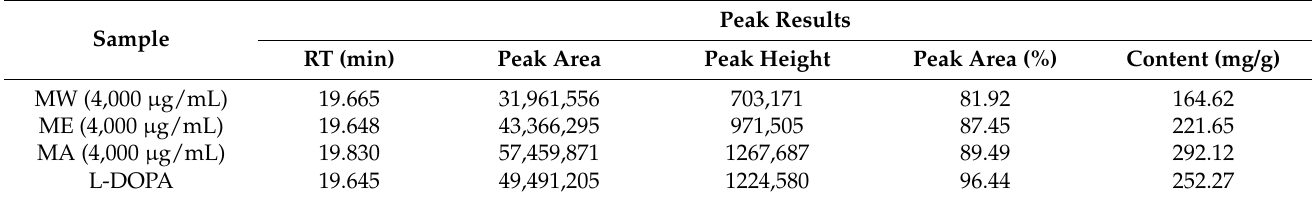
Table 1. L-DOPA content in M. pruriens extracts.